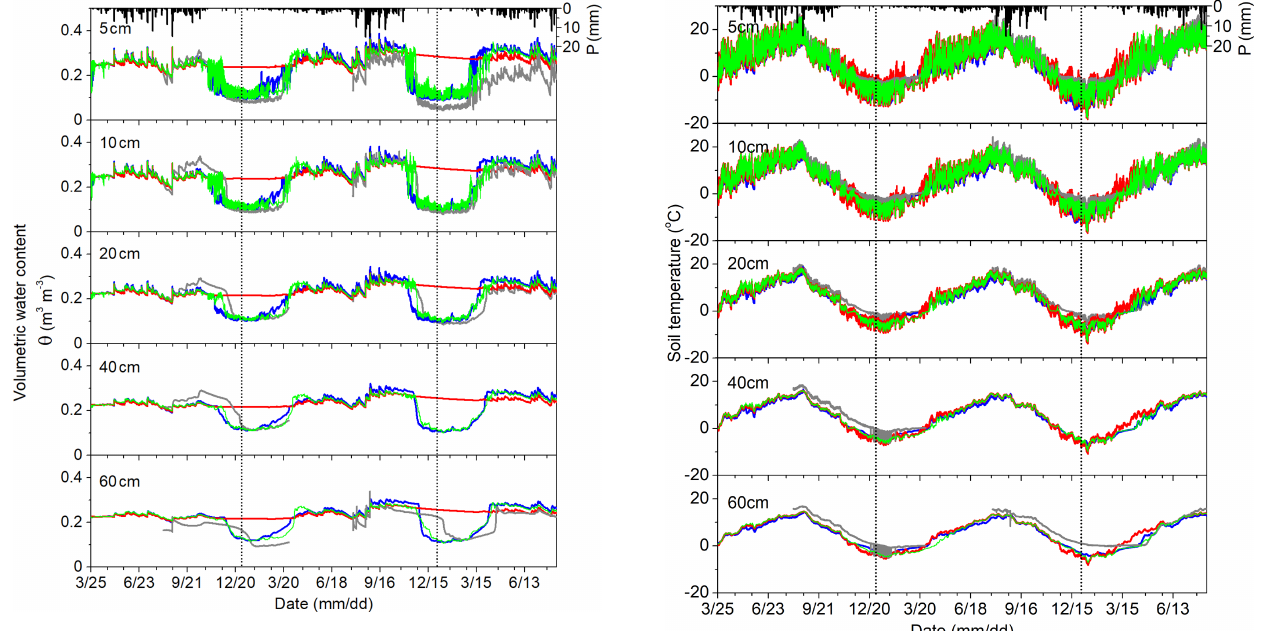
Figure 7. Measured and simulated soil temperature at various soil layers using uncoupled T&C (unCPLD), T&C with the FT process (unCPLD-FT), and coupled T&C and STEMMUS (CPLD)